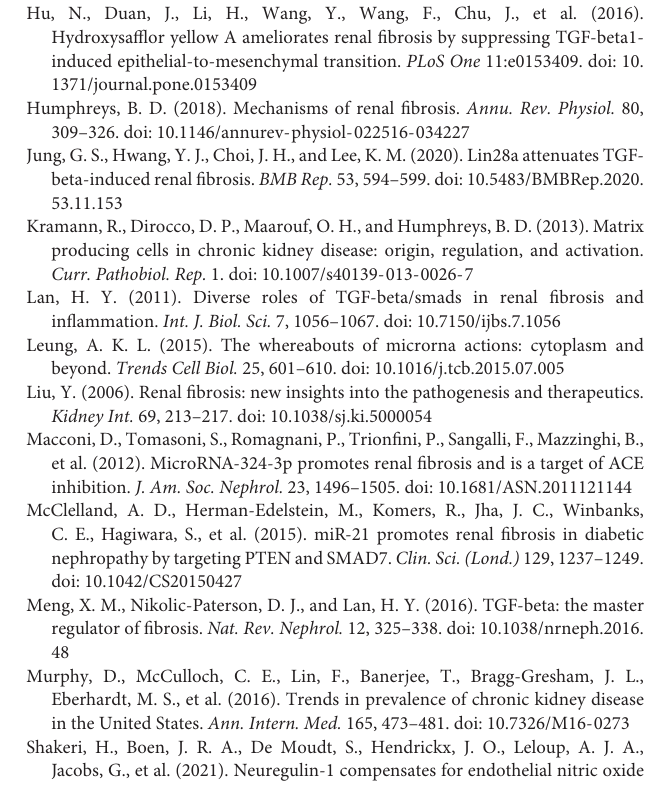
Supplementary Figure 6 | TEM observation. (A) TEM observation of autophagosomes in HK-2 cells with different treatments; (B) TEM observation of autophagosomes in HK-2 cells with different treatments; (C) TEM observation of autophagosomes in mouse renal tissues with different treatments. Supplementary Figure 7 | Immunofluorescence pictures. (A) proportion of LC3 positive cells in the HK-2 cells with different treatments by immunofluorescence assay; (B) proportion of LC3 positive cells in the HK-2 cells with different treatments by immunofluorescence assay; (C) proportion of LC3 positive cells in mouse renal tissues with different treatments by immunofluorescence assay. Supplementary Figure 8 | Western blots. (A) protein level of fibrosis markers in HK-2 cells with different treatments by Western blot; (B) Western blot results of NRG1 protein expression in HK-2 cells with different treatments; (C) protein expressions of PI3K, p-PI3K, AKT, and p-AKT in mouse renal tissues by Western blot. Supplementary Figure 9 | Determination of creatinine in mouse plasma under different treatment conditions. ∗ p < 0.05 as compared with sham, # p < 0.05 as compared with UUO + Lv-NC. The measurement data were expressed as mean ± standard deviation. Data between the two groups were compared using the unpaired t- test. Each experiment was repeated three times